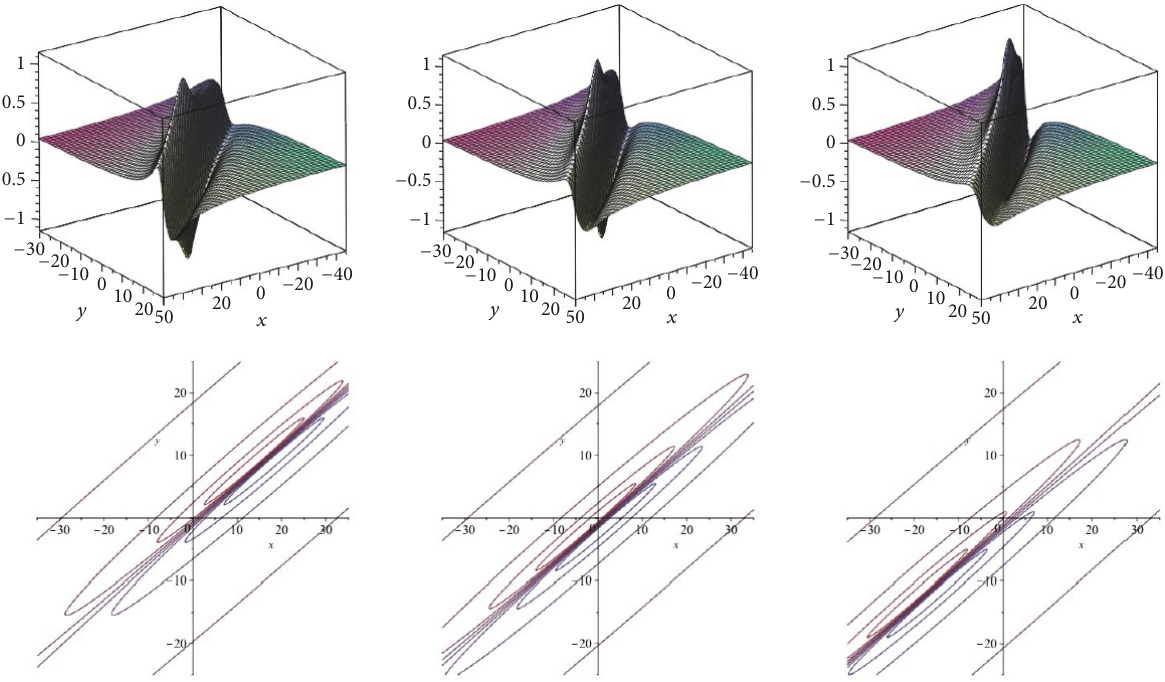
Figure 1: Profiles of 𝑢 when 𝑡 = 0,3, 6 : 3D plots (top) and contour plots